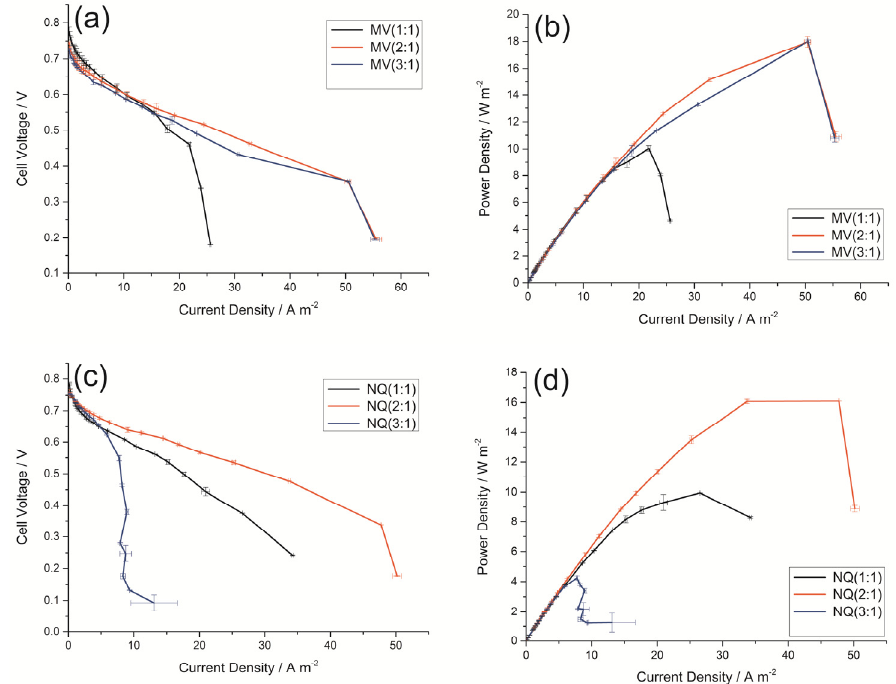
Figure 2. Polarization curves ( a ) and power density curves ( b ) of DGAFCs equipped with AC anodes fabricated with MV/AC; polarization curves ( c ) and power density curves ( d ) of DGAFCs equipped with AC anodes fabricated with NQ/AC under the condition of 1 M glucose and 3 M KOH.